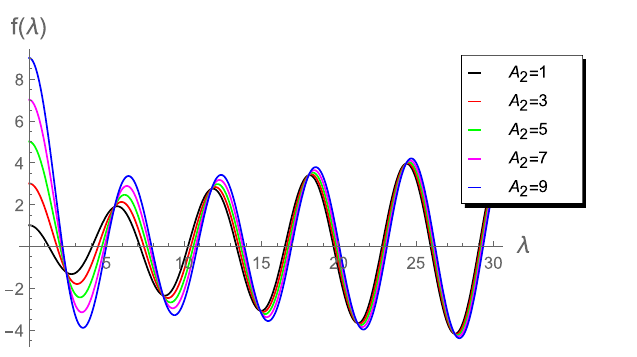
Figure 2. Plot of f ( (cid:31) ) vs (cid:31) for A 2 = { 1, 3, 5, 7, 9 }